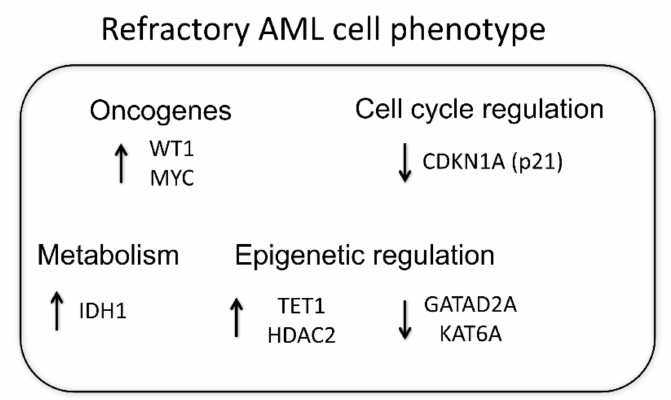
Figure 4. Proposed refractory AML phenotype. AML patients were split into two groups depending on their response to the clinical treatment. Relative gene expression analysis was performed using the RT-qPCR ∆∆ Ct method; GAPDH was used as a “housekeeping” gene. The determined statistically significant gene expression differences between refractory and responsive patients are